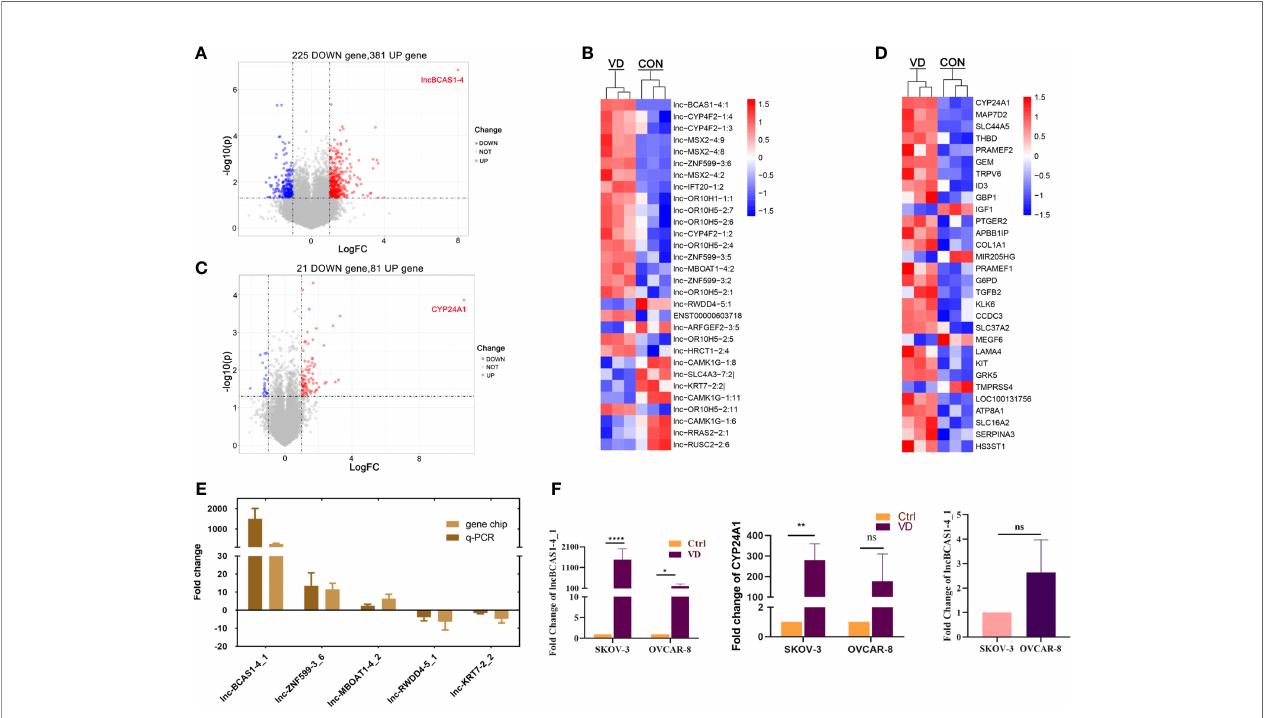
FIGURE 1 | Distributions of differentially expressed genes in ovarian cancer cells treated with 1 a ,25((OH) 2 D 3 . The ascending normalized expression level in the heatmaps is colored from blue to red. Red means gene upregulation, blue indicates downregulation, and white means normal expression. Furthermore, each column represents a sample, and each row represents a differentially expressed gene. (A) The volcanoes of 606 DE lncRNAs; (B) the heatmaps of DE-lncRNAs; (C) the volcanoes of 102 DE-mRNAs; (D) the heatmaps of DE-mRNAs; (E) the validation of DE-lncRNAs by quantitative RT-PCR; and (F) the expressions of most-regulated lncBCAS-1_4-1 and CYP24A1 in SKOV3 and OVCAR8 treated by 1 a ,25(OH) 2 D 3 . * p < 0.05, ** p < 0.01, ****p < 0.0001, NS, not signi fi